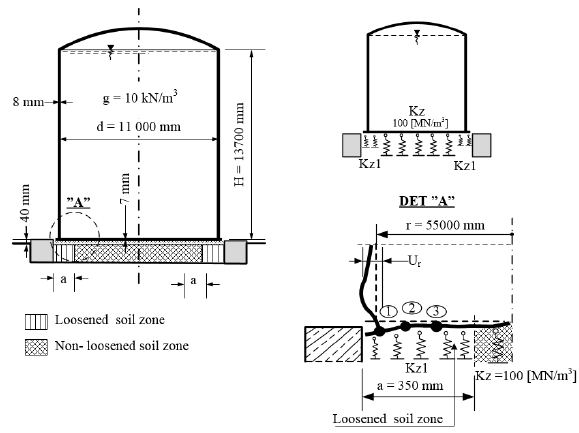
Figure 6: Geometry of the analyzed steel tank on a type C foundation with loosened soil zone ( K and u of the shell. r